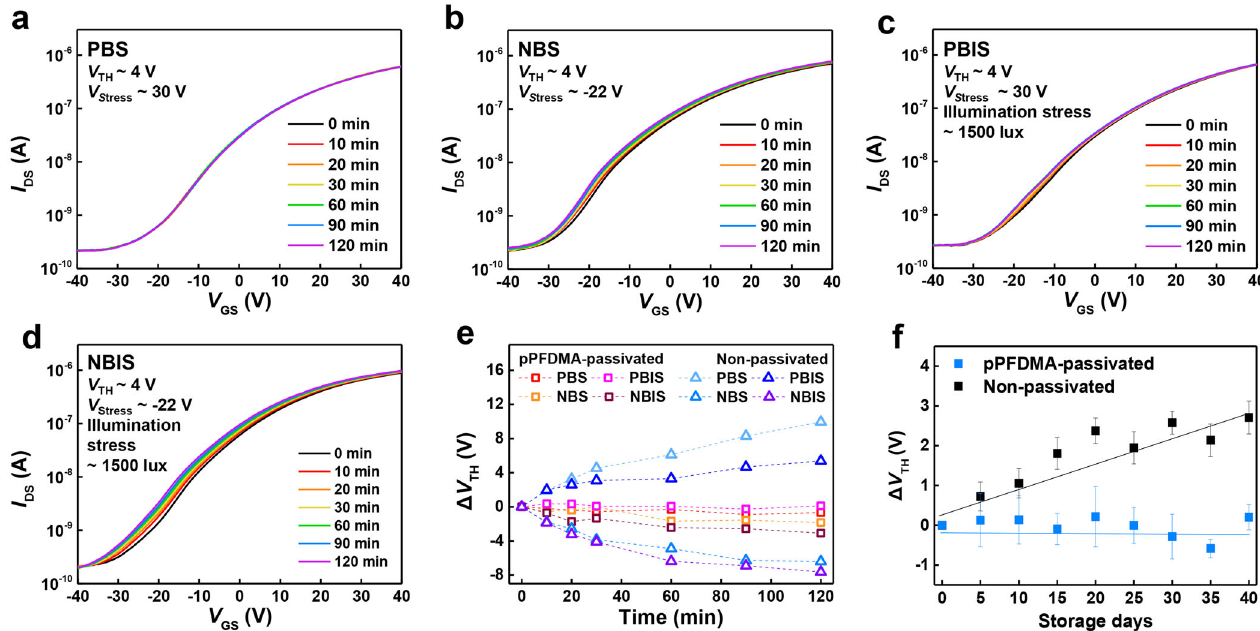
Fig. 5 Gate bias and illumination stress tests and long-term storage test of pPFDMA-passivated nanoporous MoS 2 TFTs. Transfer characteristics of the pPFDMA-passivated nanoporous MoS 2 TFT under a PBS, b NBS, c PBIS, and d NBIS conditions with positive bias stress of 30 V and negative bias stress of − 22 V. A light source of 1500 lux was used for the illumination stress. e Variation of V TH of nanoporous MoS 2 TFT passivated with pPFDMA layer and non-passivated one according to the stress time. f Long-term storage test of pPFDMA-passivated and non-passivated nanoporous MoS 2 TFTs under exposure in the ambient